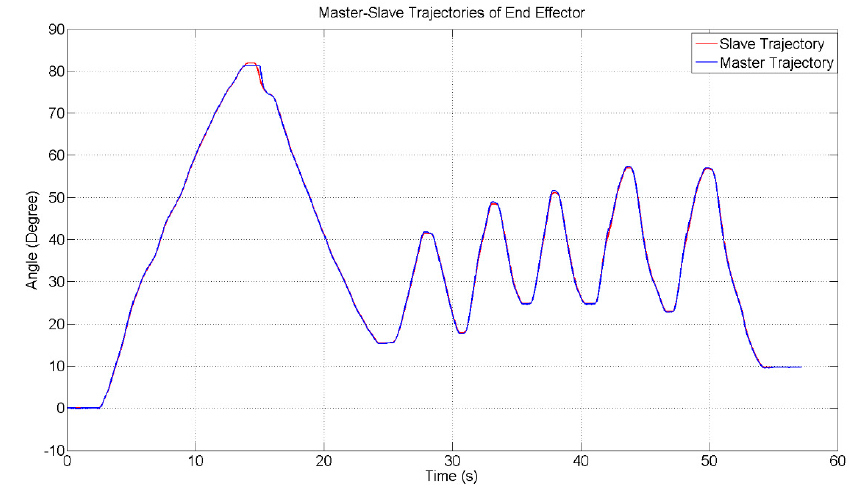
Figure 11. Master–slave trajectories for end effector.